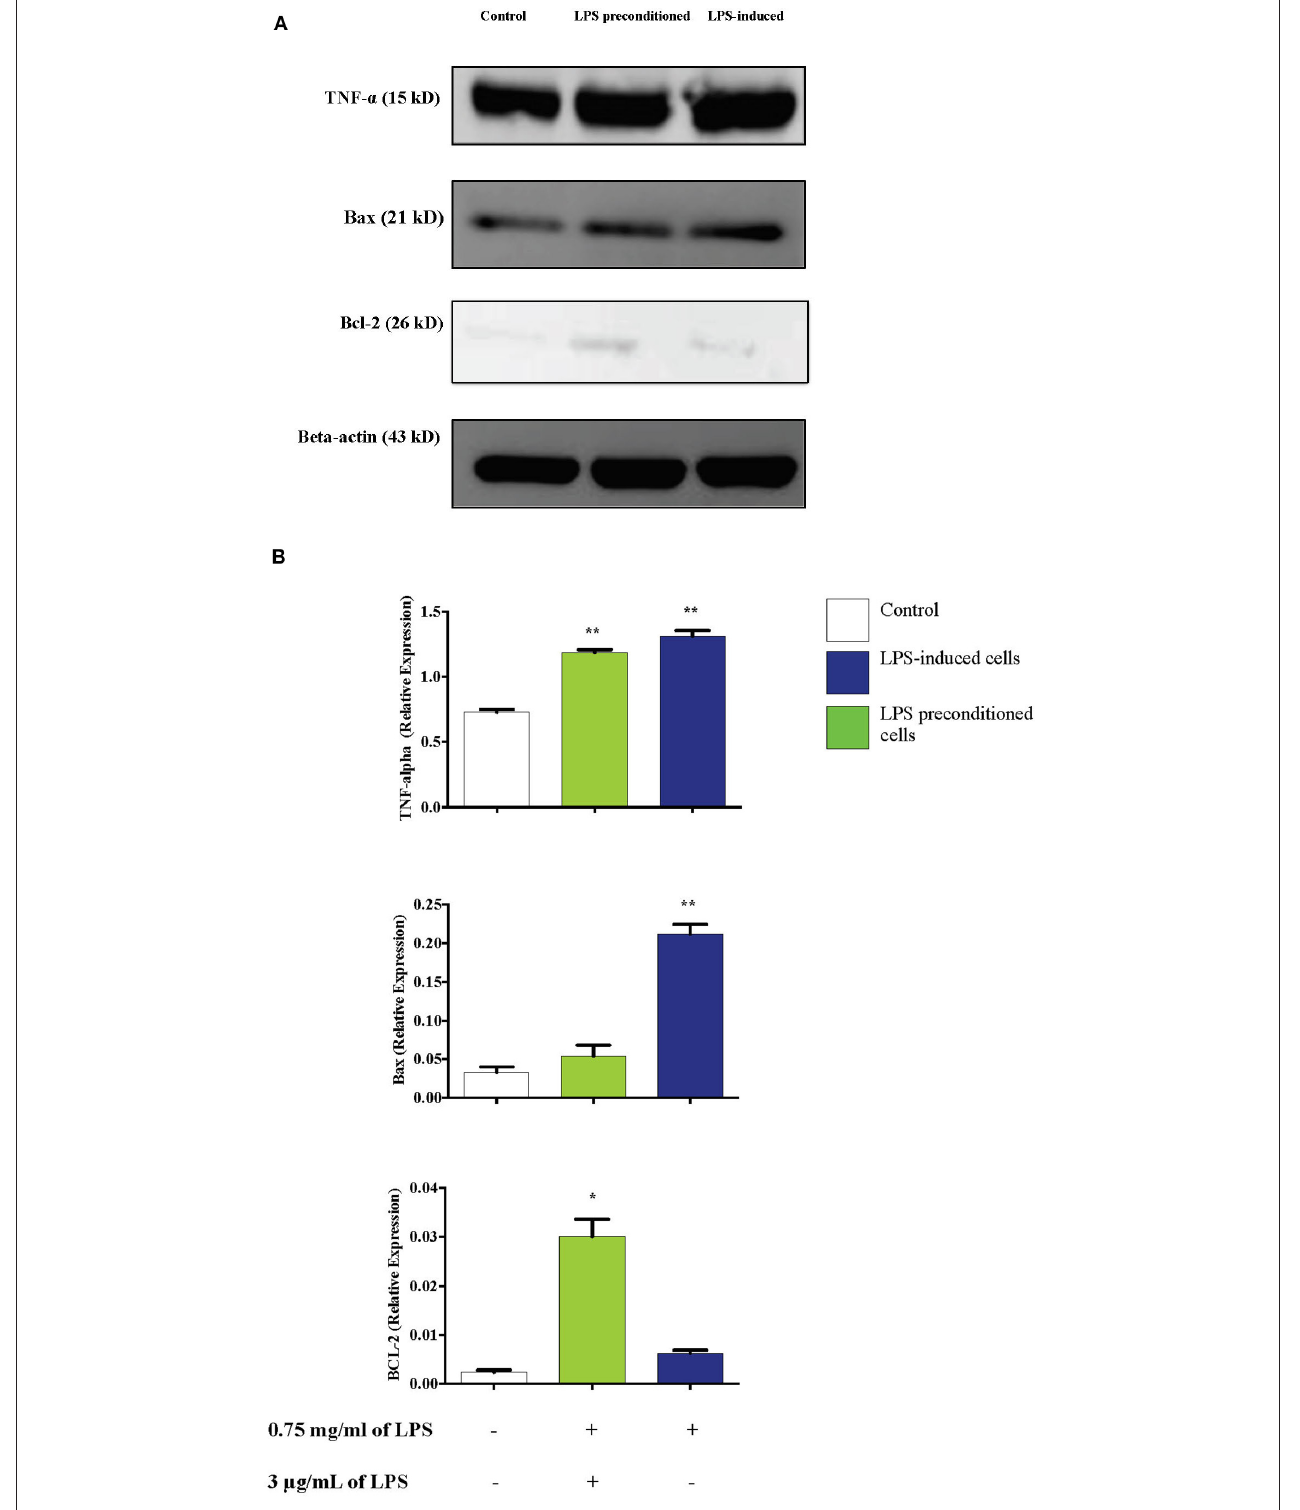
FIGURE 17 | Effect of LPS on TNF- α , Bax, and Bcl-2 protein expressions in LPS-induced and LPS-preconditioned cells. The expressions of inflammatory cytokine, TNF- α ; pro-apoptotic protein, Bax; and anti-apoptotic protein, Bcl-2 were determined in whole cell lysates by western blotting. (A) Band densities were measured by densitometric analysis, and data were normalized to control and expressed as fold change relative to beta-actin. (B) Bars represent data from three independent experiments. TNF- α , Bax, and Bcl-2 expressions in cells that were stimulated with LPS were compared to control. * p < 0.05, ** p < 0.01 as determined by one-way ANOVA with Bonferroni’s